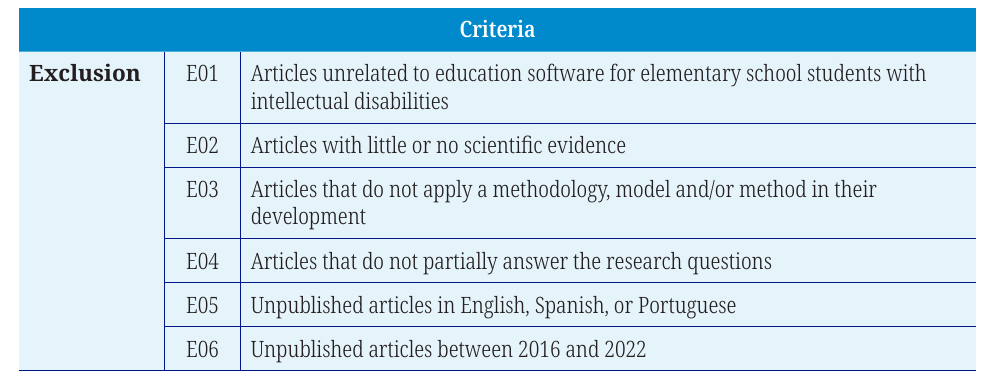
Table 1. Inclusion and exclusion criteria